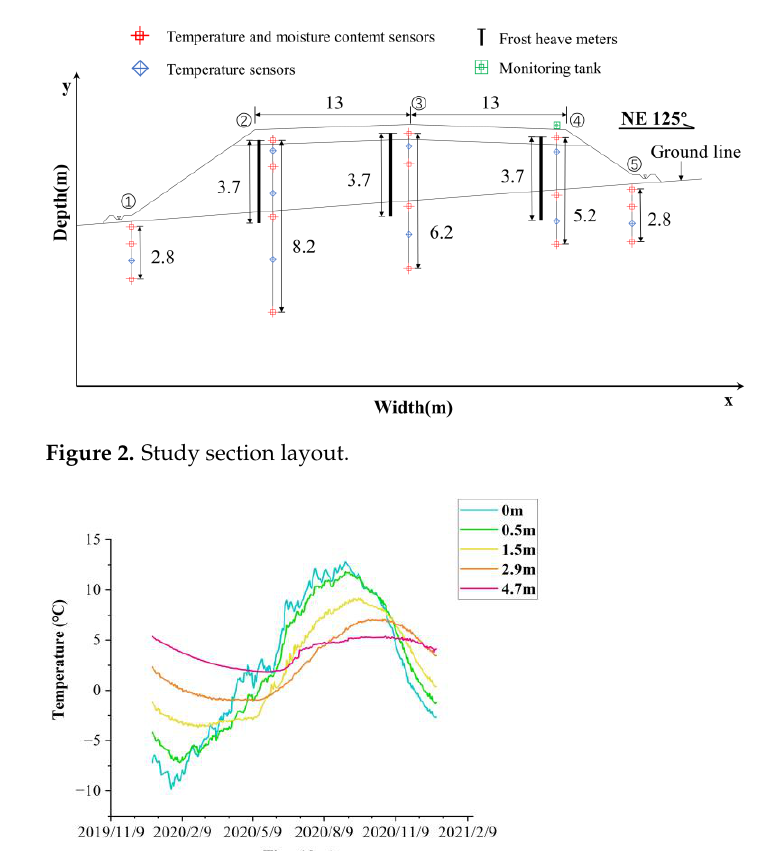
Figure 2. Study section layout.